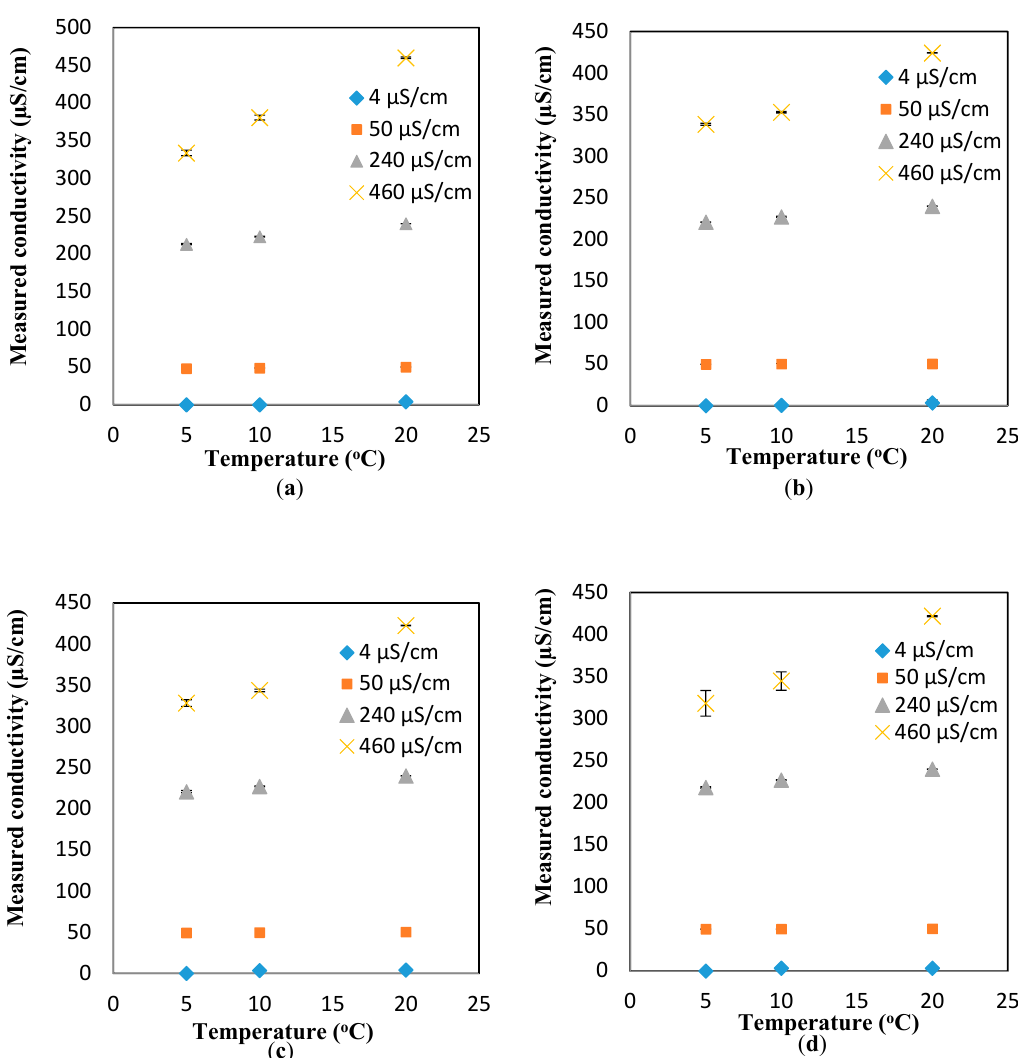
Figure A8. Effect of temperature on the response of the conductivity sensor for different conductivity solutions at the flowrates of ( a ) 0 mL/min; ( b ) 10 mL/min; ( c ) 20 mL/min; and ( d ) 30 mL/min.